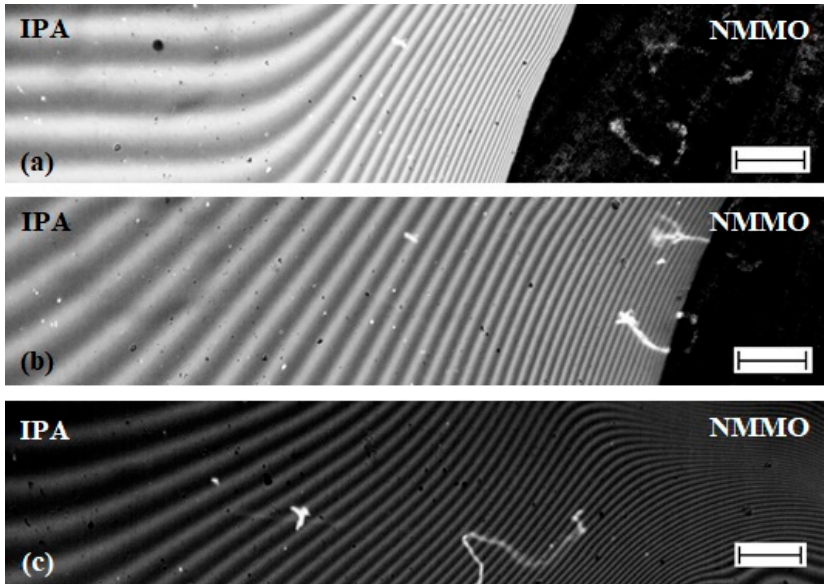
Figure 6. Interferograms of the interaction zone of the NMMO–isopropanol system at temperatures: of 30 °C ( a ); 60 °C ( b ); and 85 °C ( c ). The length of the scale bar is 250 microns.